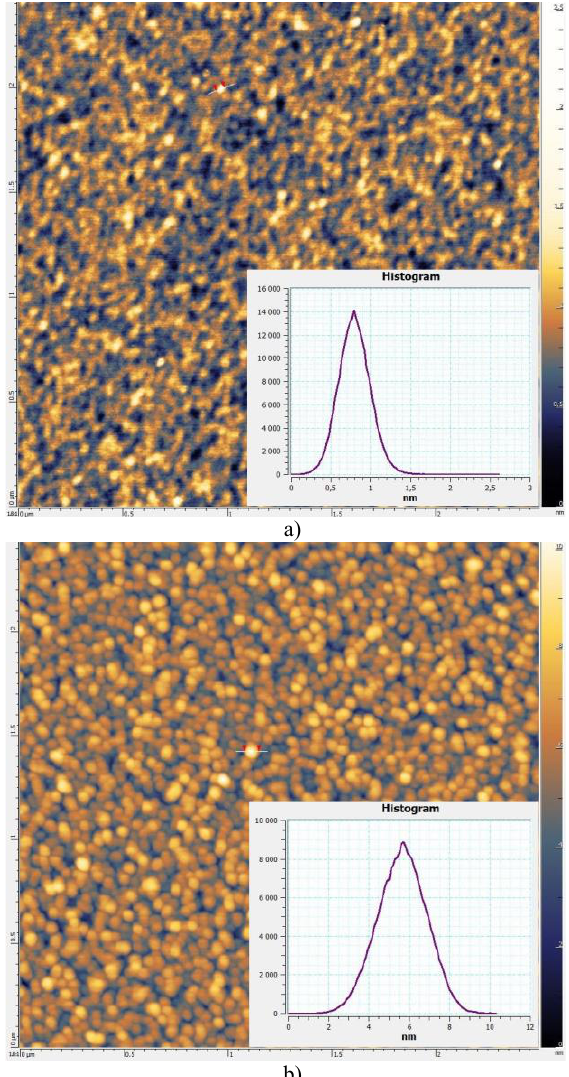
Fig. 2. The image of the grain in the dark field obtained on a transmission electron microscope. a) the substrate temperature during the deposition was 270 ° C; b) the substrate temperature during the deposition was 390 °C.